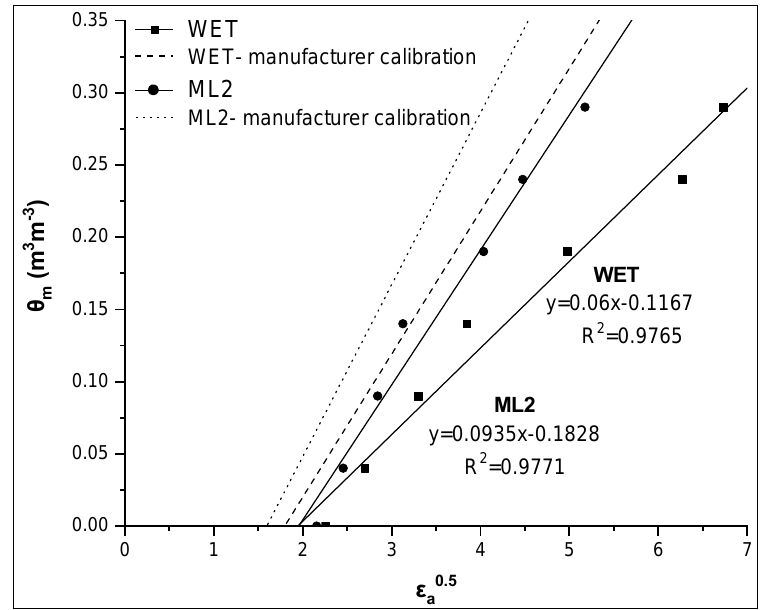
Figure 6. Comparative presentation of the relationships θ m ‐ε a0.5 obtained by the WET and ML2 sensors for soil 2. The corresponding relationships using the manufacturer calibration are also given for both sensors.